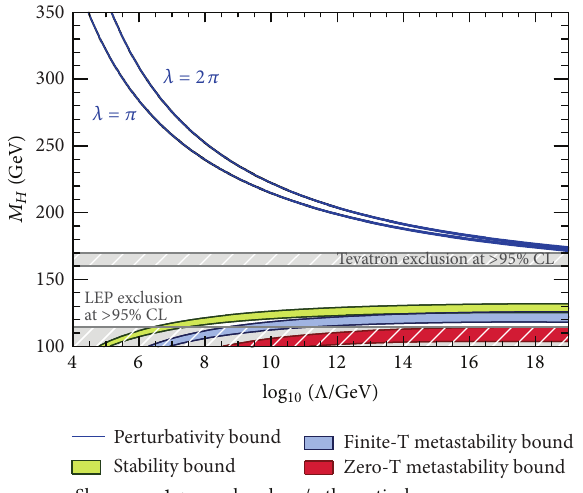
Figure 10: The Higgs boson mass as a function of the scale Λ up to which the SM may remain valid was obtained from perturbativity (solid dark blue line) and the stability of the electroweak vacuum (shaded regions). The figure is taken from